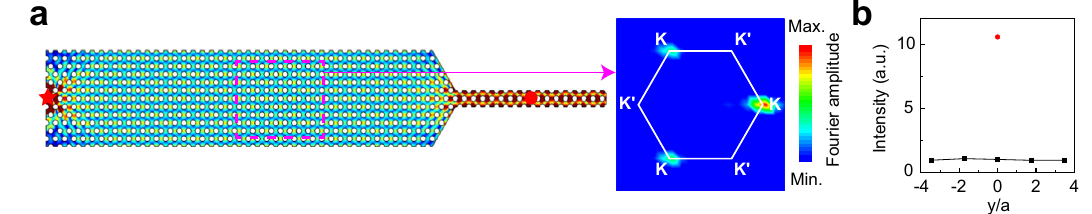
Fig.5|Valley-lockedfocusingbasedontheCABSs.a Simulatedacousticpressure fi eld distributions at 15.5kHz for a point source (red star) on the left of the PC, demonstratingthefocusingeffect.Rightpanel:theexperimentalFourierspectrum